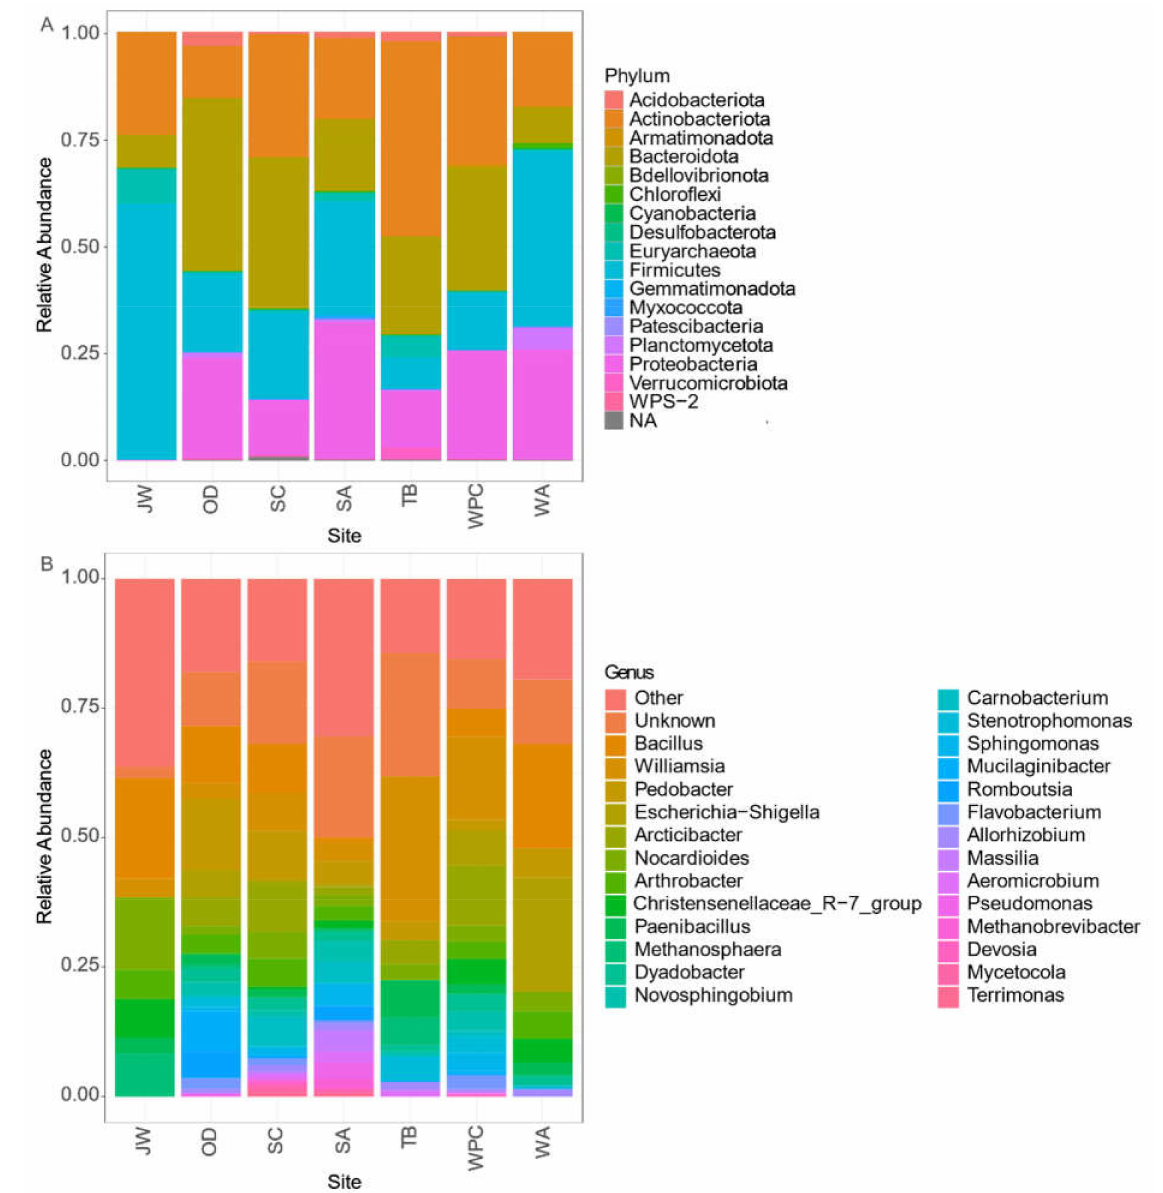
Figure 2. Bar charts representing the relative abundance of the total 16S rRNA sequence, taxonomically classified at the ( A ) phylum level and ( B ) genus level. Abbreviations: JW = Juwangsan National Park; OD = Odaesan National Park; SC = Samcheok Area; SA = Seoraksan National Park; TB = Taebaeksan National Park; WPC = Wangpicheon Conservation Area; WA = Woraksan National